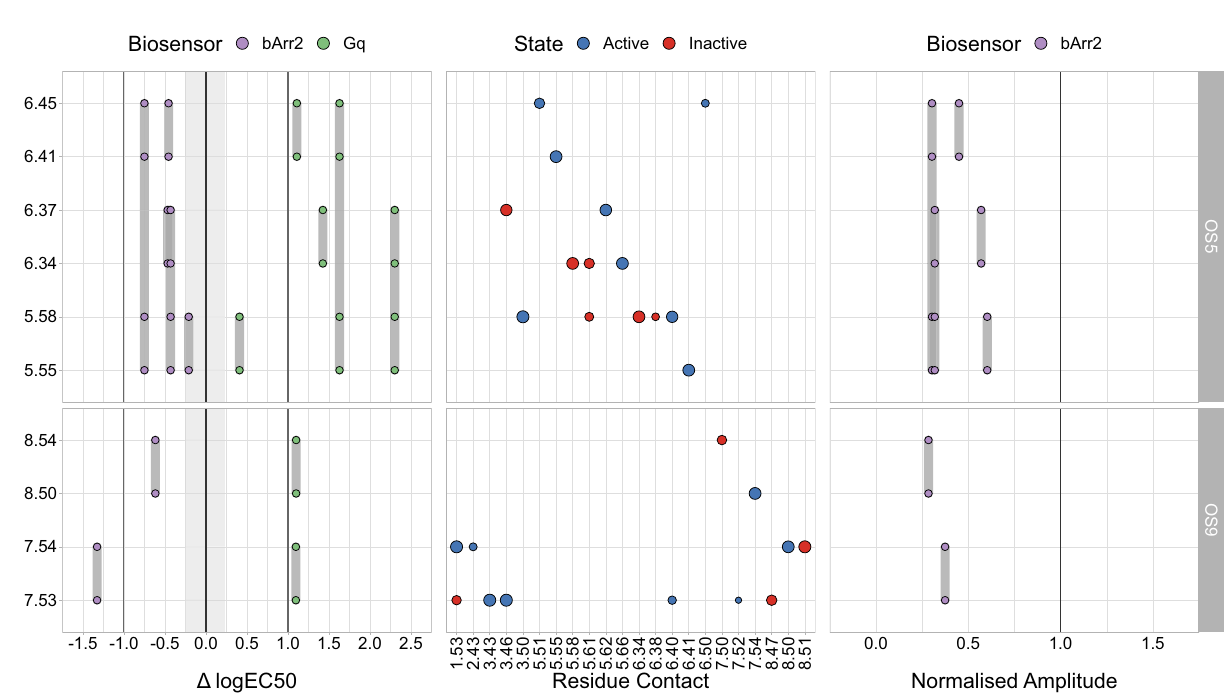
Fig. 3 Experimental data for OS5- and OS9-mutants in the M 3 R. The y-axis depicts the position of the pocket residues (Ballesteros-Weinstein numbering 35 ). Grey lines linking the points connect the respective double and quadruple mutants. The left panel shows the difference between the mutant (cid:1) logEC wt logEC 50 and the mean wildtype (wt) logEC 50 values (logEC mut ) and the right panel the normalised amplitude (Amp mut /Amp wt ) of the extent to 50 50 which β -arrestin2 was recruited. While in the left plot a value of 0 corresponds to no potency changes, a value of 1 in the right plot corresponds to no changes in ef fi cacy compared to wt. The greyed out area indicates minimal and maximal potency shifts of multiple G α q wt measurements. The central panel depicts interhelical residue contacts of each of the mutated residues that are important in active (blue) or inactive (red) conformations of class A GPCRs in a similar manner to Supplementary Fig. 10 (normalised PCA coef fi cient cut-off: 0.5). The point size correlates with the normalised PCA coef fi cient for a given contact and can be seen as a direct measurement of importance for a given state. Source data are provided as a source_data.xlsx fi